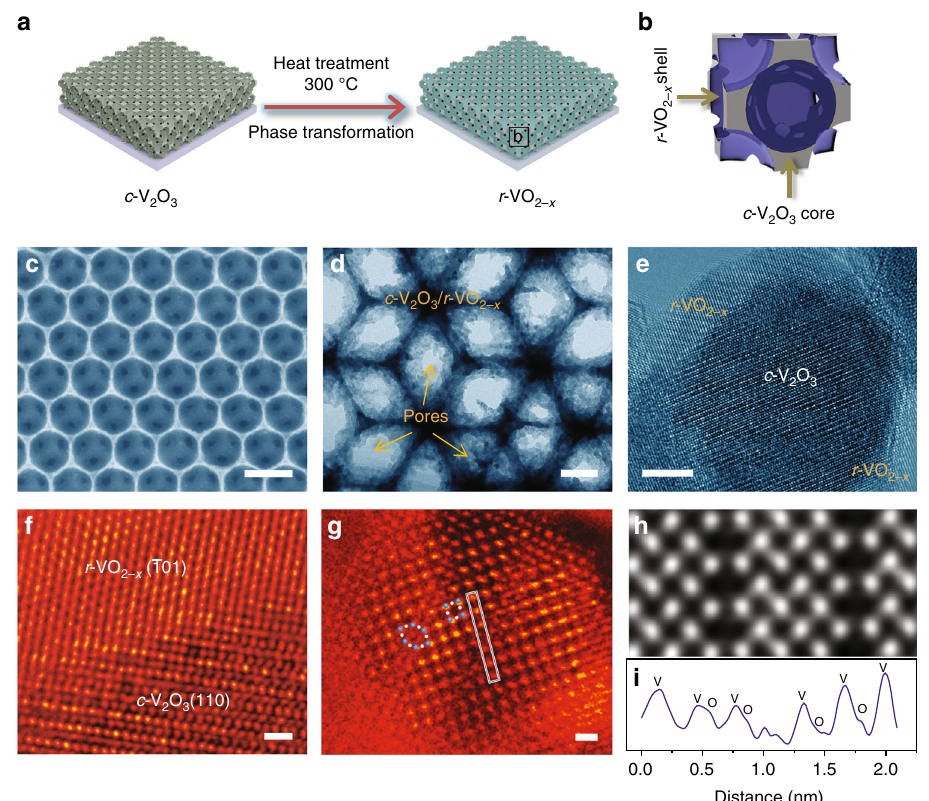
Fig. 2 Preparation and structural characterization of isomeric vanadium oxides. a Scheme for in situ corundum-to-rutile-phase transformation triggered by thermal oxidation to fabricate hierarchical nanoporous isomeric c -V 2 O 3 / r -VO 2 − x from precursor 3D V 2 O 3 skeleton. b Core/shell structure of isomeric of c - V 2 O 3 / r -VO 2 − x . c SEM image of nanoporous c -V 2 O 3 / r -VO 2 − x fi lms with an ordered macroporous structure. Scale bar, 500 nm. d – f Bright- fi eld TEM and HR-TEM images of c -V 2 O 3 / r -VO 2 − x core/shell structure ( d , e ) and epitaxially interfacial structure ( f ). Scale bar, 100 nm ( d ), 5 nm ( e ) and 1 nm ( f ). g HAADF-STEM image of the r -VO 2 − x layer viewed from the [001] axis, demonstrating an alternating structure of quasi-hexagonal tunnels and rutile slabs. Scale bar, 0.5 nm. h Simulated HAADF-STEM image of quasi-hexagonal tunnel structure in ( g ). i Line pro fi le of column of atoms in the white boxed